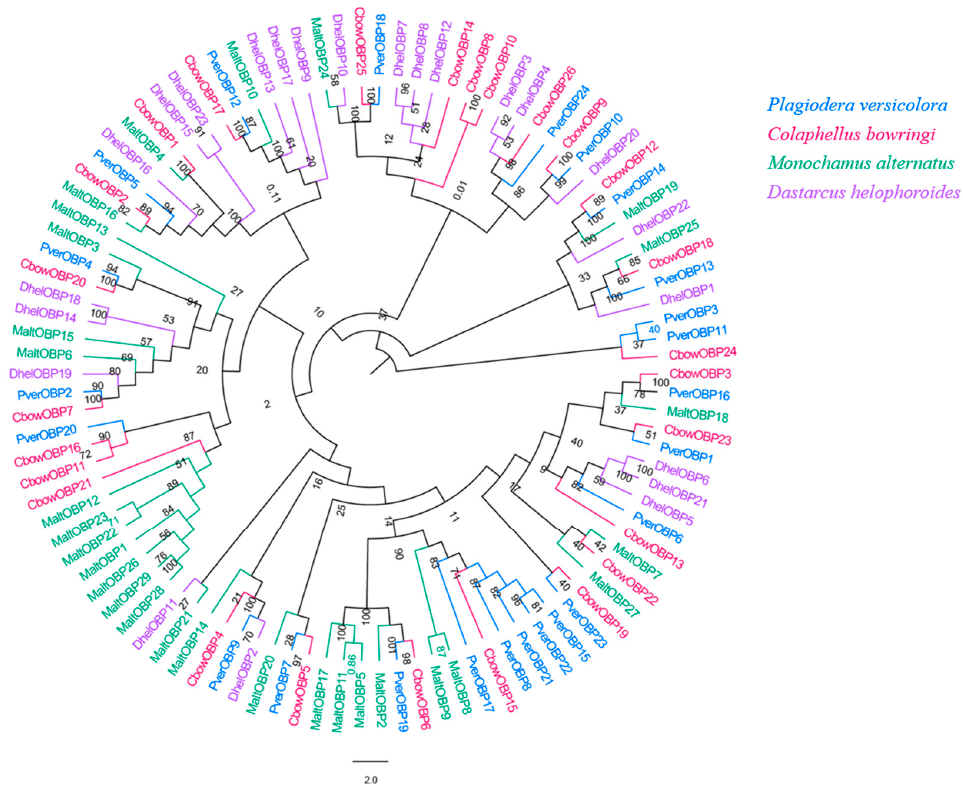
Figure 3. Phylogenetic tree of insect OBP. The P. versicolora genes are shown in blue. The tree was constructed using MEGA6 with the Neighbor-joining method.